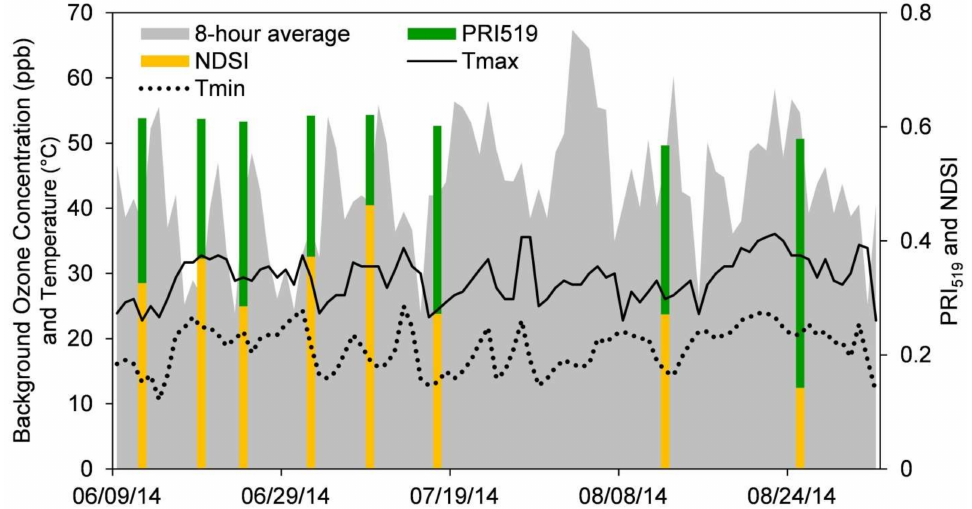
Figure 11. Temporal variation in daily 8-h average ambient ozone concentrations (ppb); daily minimum ( T min , ◦ C) and maximum air temperature ( T max , ◦ C); PRI 519 and